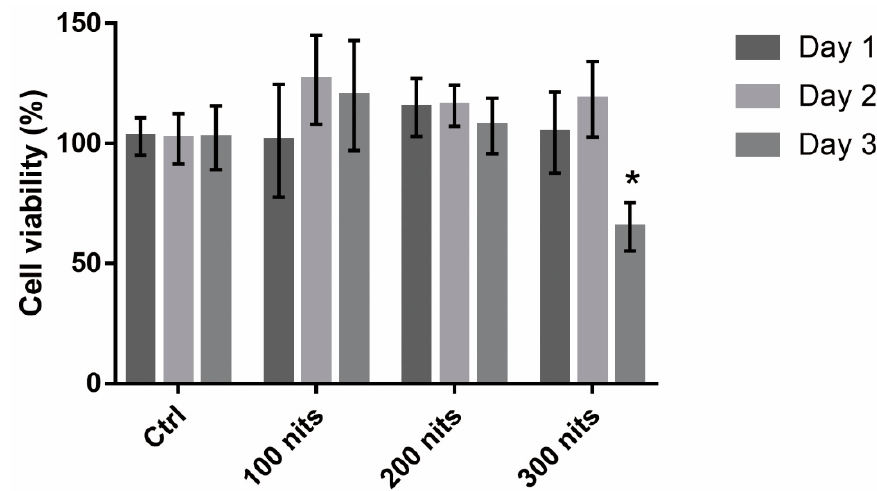
Figure 1. Viability of 661W cells exposed to liquid crystal displays with different luminance for 1, 2, and 3 days. Cell viability was analyzed using alamarBlue assays. Ctrl: control group, no light exposure; All data represent the means ± SD. *p < 0.05 compared to data on day 1 using two-way analysis of variance (ANOVA) with post hoc Dunnett's multiple comparisons test ; n = 16 per group.